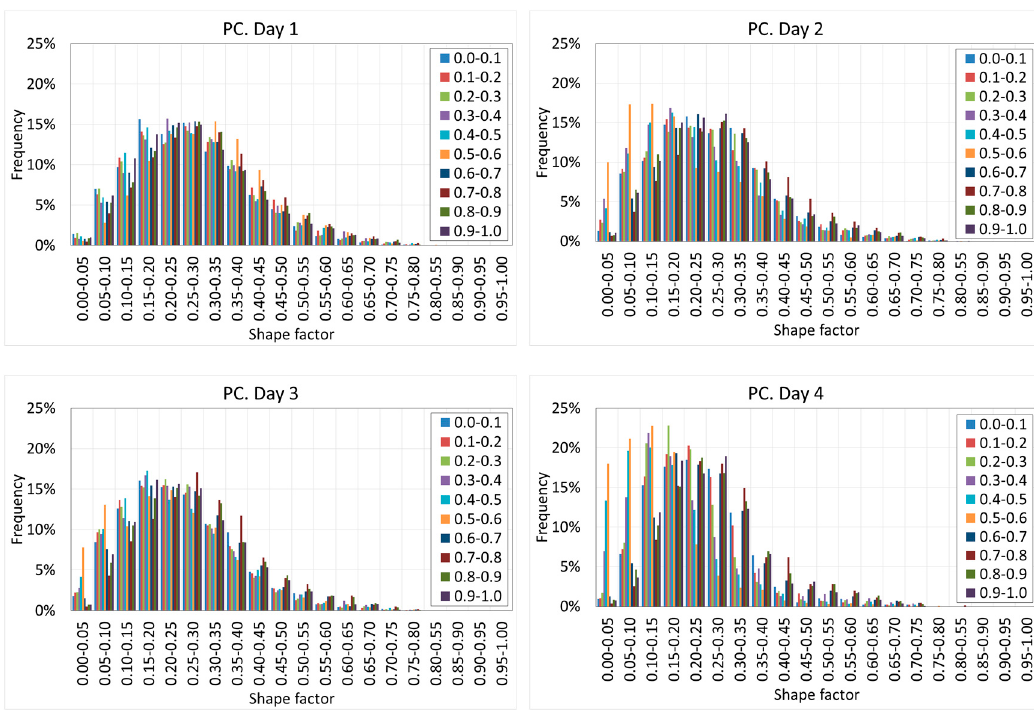
Figure 22. Histograms of the shape factors of SFRC at different depths and ages.